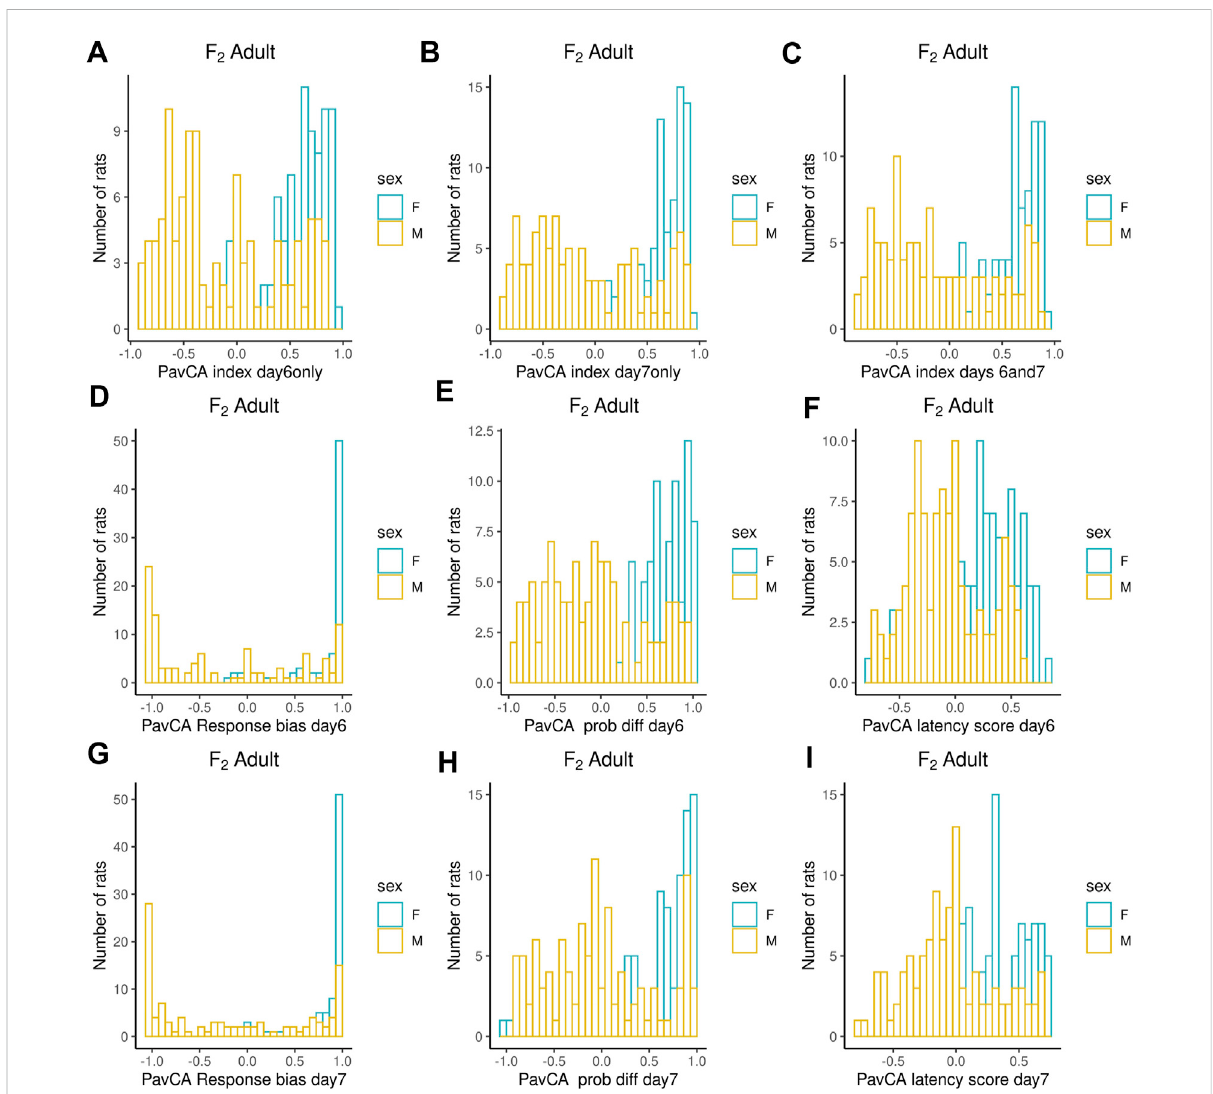
FIGURE 3 Frequency histograms showing the distribution of PavCA traits in F 2 males and females prior to quantile normalization of the data. (A – I) PCA index from the last two test days (6 and 7) alone and the 2 days combined, as well as the three metrics used on each day to calculate the PCA